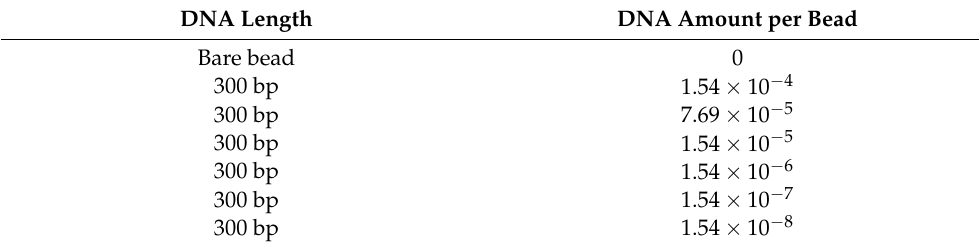
Table 1. Model outputs [5]. DNA